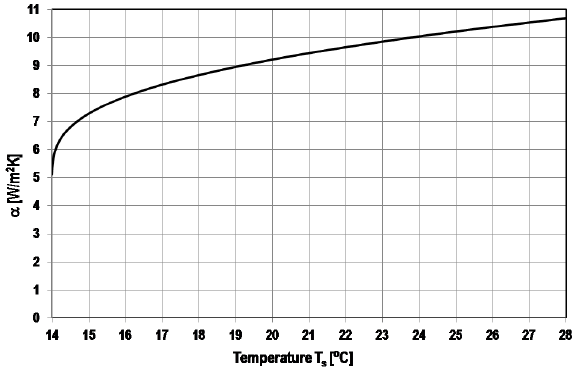
Figure 4: Graph of dependence of the heat transfer coeflcient on a temperature of the floor